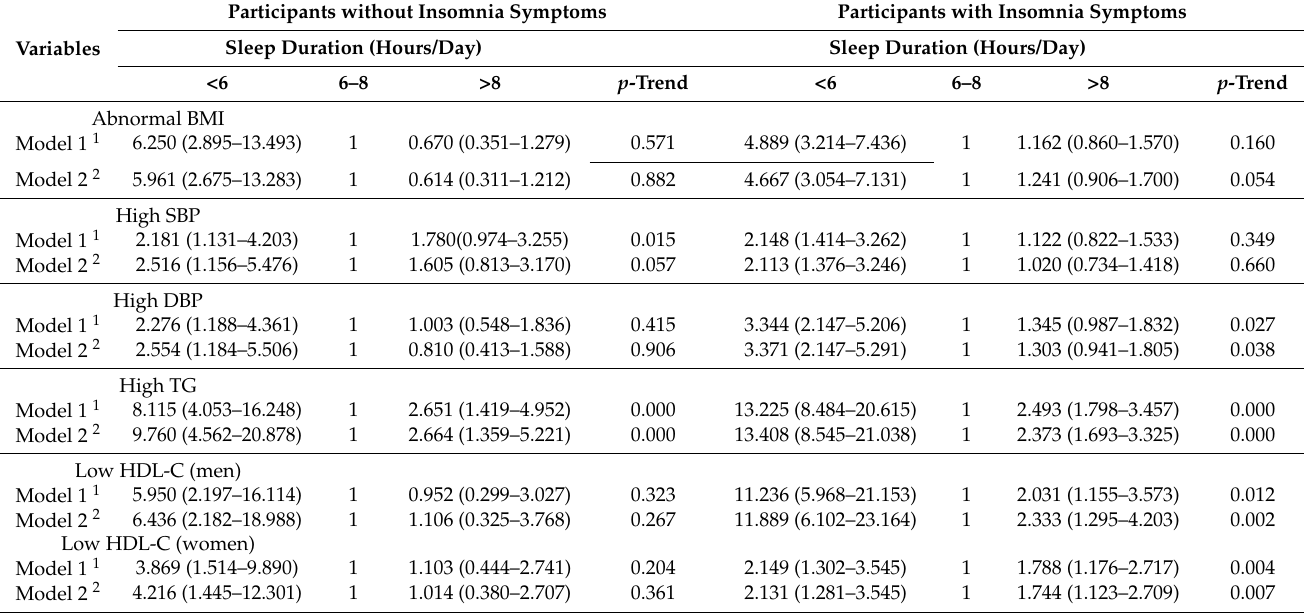
Table 4. Odds ratios (95% CI) of the components of metabolic syndrome across participants with or without insomnia symptoms (N =